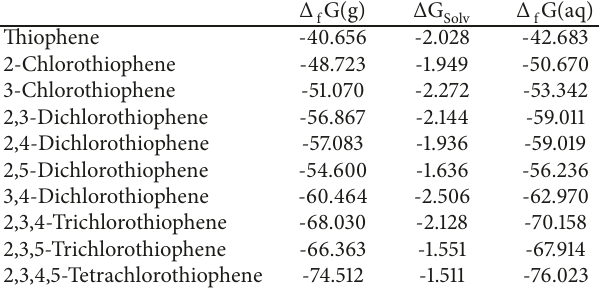
Table 3: The calculated properties of chlorinated thiophene at 298 K: the Gibbs free energies in the gas phase G f (g), the Gibbs free (cid:2) 𝐻 o energies for solvation (G Solv ), and the standard and relative Gibbs 𝑓 298 free energies in aqueous phase G f (aq). All are in